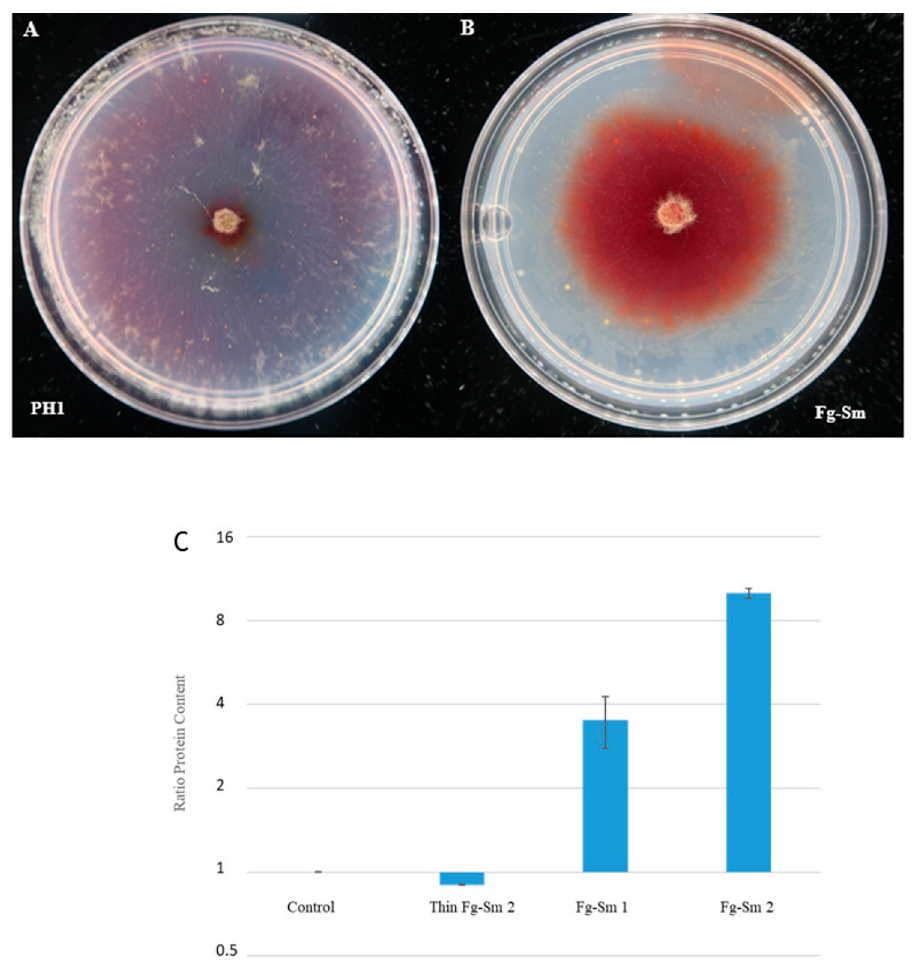
Figure 6. Nitrogen fixation capability of Fg- S. maltophilia vs. PH-1. Both cultures were grown on a nitrogen-free synthetic medium supplemented with gentamicin (0.512 mg/L) with only glucose as a carbon source and no nitrogen source. Plates were extracted for total protein determination when the control cultures had grown to the plate edge. ( A ) At that time, the thin growth of the Fg- S. maltophilia cultures had also reached the plate edge, as had the thin growth outer part of the Fg- S. maltophilia cultures. ( B ) The image is from a few days later of plates that had not been used for protein extraction to measure the protein content and confirmed that the dense red area expands over the thin area at the edge using the surplus carbon source that cannot be fully utilised without available nitrogen. ( C ) The ratio of protein content for Fg- S. maltophilia (or PH-1 control)/PH-1 control in different areas. Two independent experiments were used to confirm the high protein content of the Fg- S. maltophilia deep red colony areas (Fg- S. maltophilia 1 and 2). Error bars are 95% confidence intervals. Bars with non-overlapping error bars are significantly different ( p same < 0.05). Pairwise t -test comparisons gave the following p values for the relative protein content per area compared to the control (PH1): the thin external expanding growth of Fg- S. maltophilia = 0.74, Fg- S. maltophilia experiment 1 = 0.028, Fg- S. maltophilia experiment 2 = 0.0034. Since the data are ratios, they are log-normally distributed, and all statistics were calculated on the log data values.